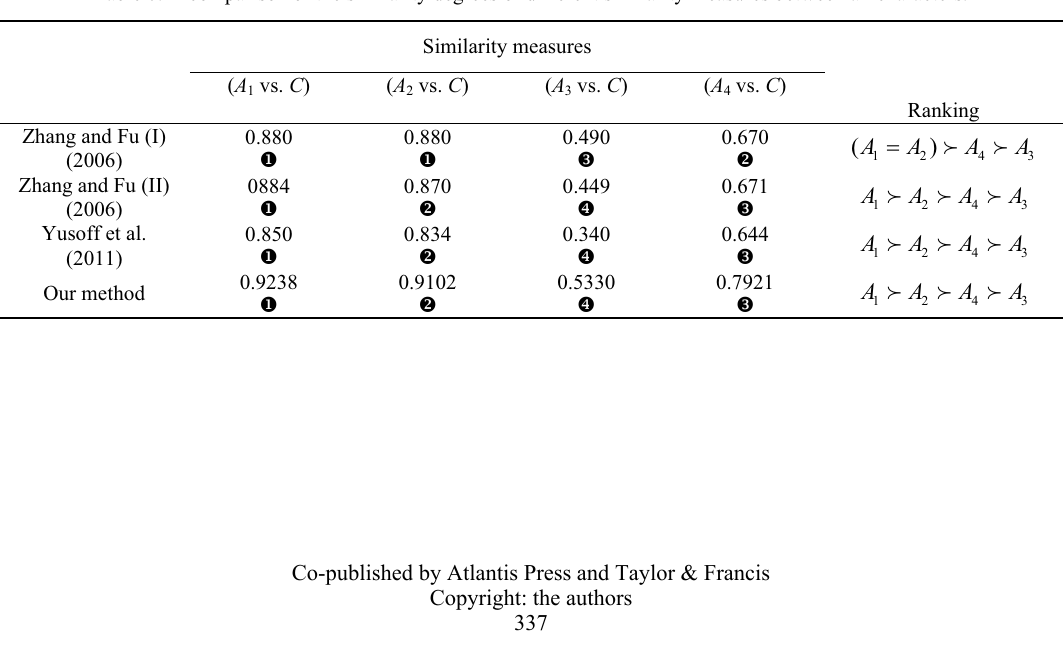
Table 6. A comparison of the similarity degrees of different similarity measures between all